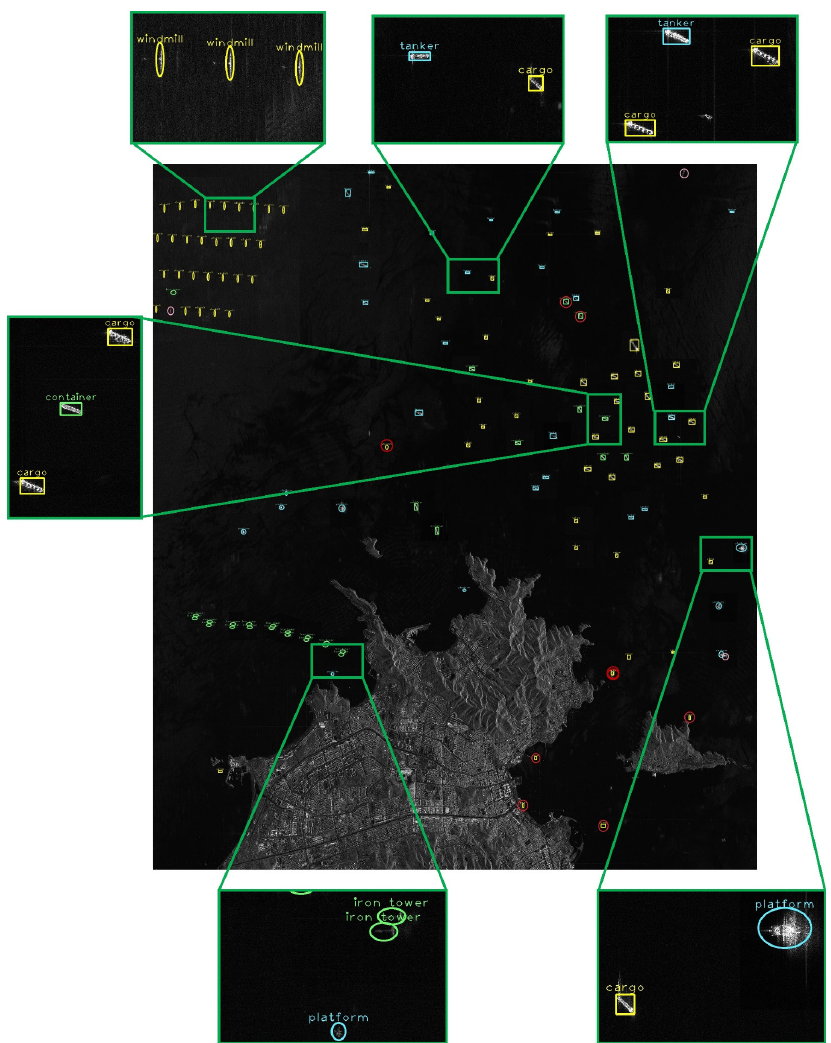
Figure 8. Detection results of a large-scale SAR image. The red circles and pink circles denote the false alarms and missed targets, respectively. Cargo, container ship, and tanker are labelled by yellow, green, and blue rectangles, respectively. Yellow eclipses, green eclipses, and blue eclipses indicate windmills, iron towers, and